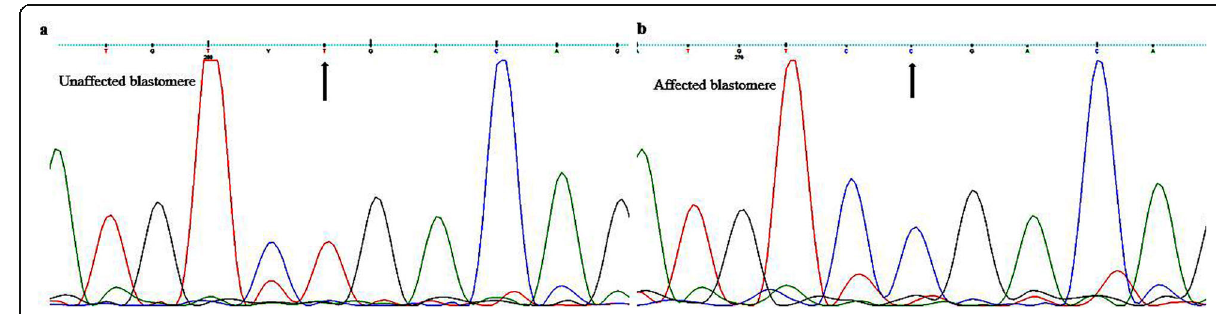
Fig. 3 Sequence chromatograms of ( a ) unaffected and ( b ) affected